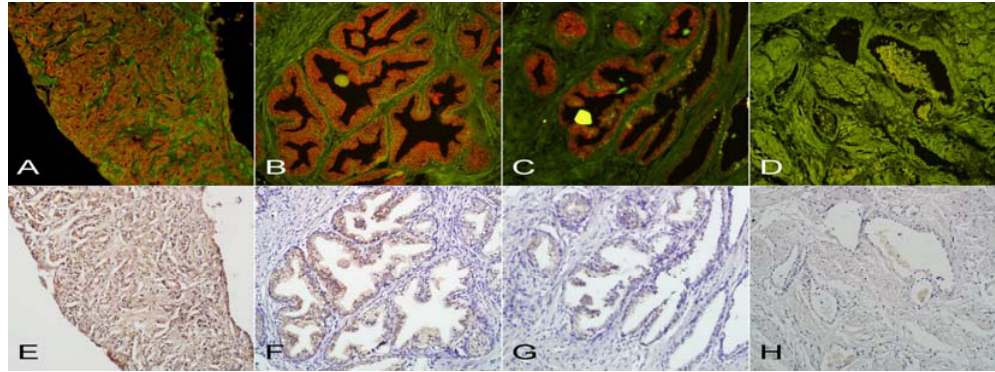
Figure 1. The levels of PSCA expression by QDs labeling and IHC. Under excitation of blue light, ( A–C ) show the positive expression of QDs-IHC at 3+, 2+, and 1+ and ( D ) was the negative control. ( E–G ) are the positive expression of IHC at 3+, 2+, and 1+ and ( H ) was the negative control. (All magnifications: 200×).